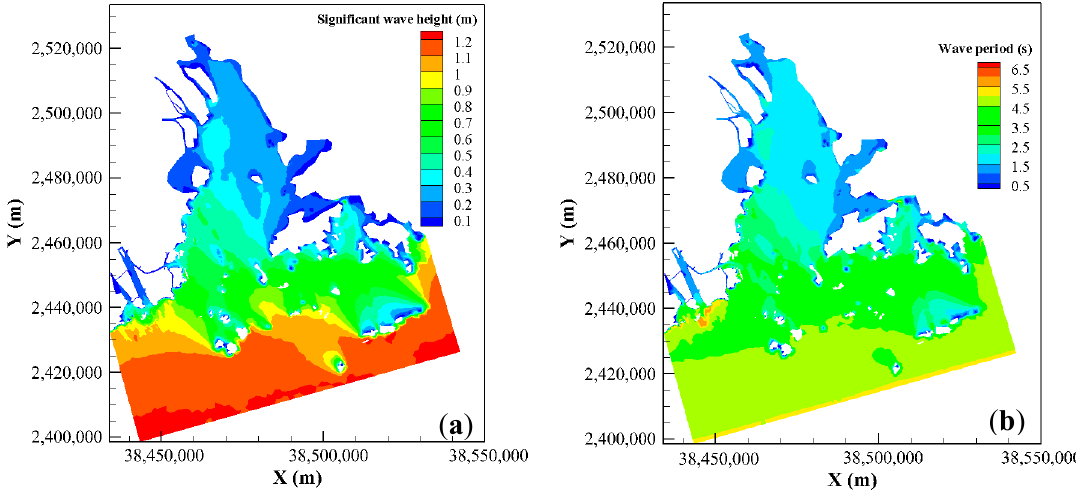
Figure 8. Sandbar simulation: the distribution of ( a ) significant wave height and ( b ) wave period.